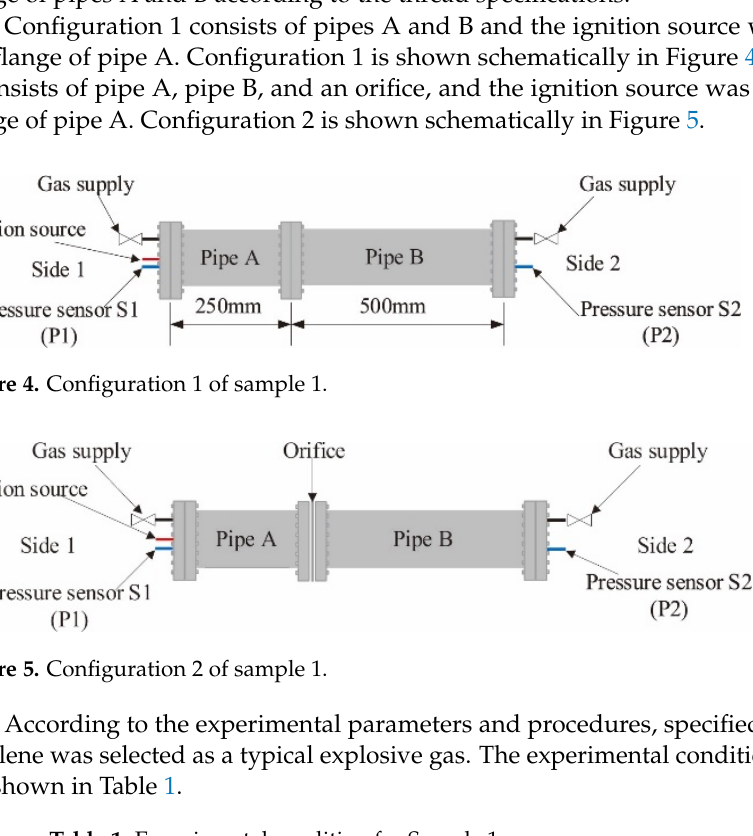
Table 1. Experimental condition for Sample